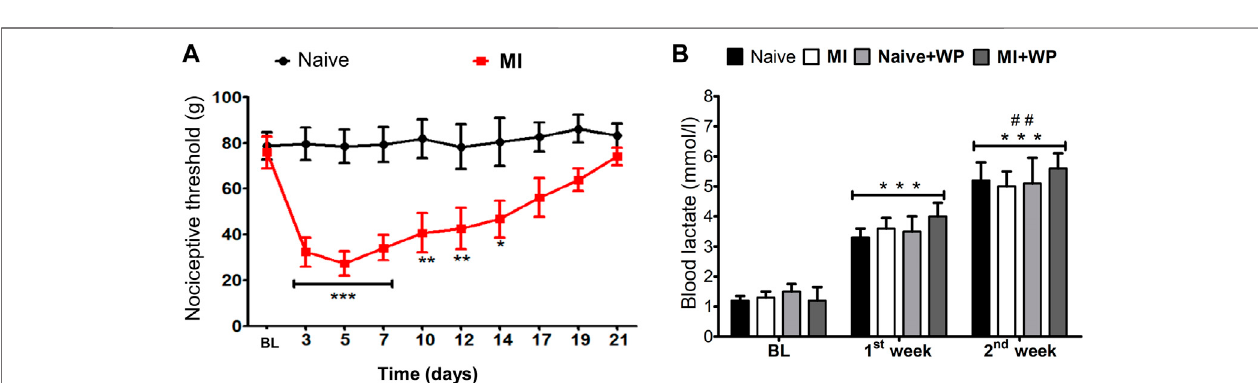
FIGURE 2 | Effect of the muscle injury on the nociceptive threshold and of resistance exercise on the blood lactate levels. First, the baseline nociceptive threshold (BL) of each animal was measured and then the muscle injury (MI) wasinduced (A) . After that, and every 2 days from the 3rd tothe 21st day, anew measurement of the nociceptivethresholdwasperformed. (B) Bloodlactatelevelsweregivendosagebefore(BL)andafterthe1stand2ndweeksofresistanceexercisetraining(RET)and/or whey protein (WP) supplementation in rats with MI or naïve (without MI). Data are expressed as the mean ± S.E.M. of six animals per group. In (A) , * p < 0.05, ** p < 0.01,and *** p < 0.001indicatestatisticalsigni fi cancecompared tothenaïvegroup;in (B) ,*** p < 0.001indicatesstatisticalsigni fi cancecomparedtobaselinelevels(BL); ## p < 0.01 indicates statistical signi fi cance between the 1st and 2nd weeks. (A) Two-way ANOVA followed by the Bonferroni post hoc test; (B) one-way ANOVA was followed by the Bonferroni post hoc